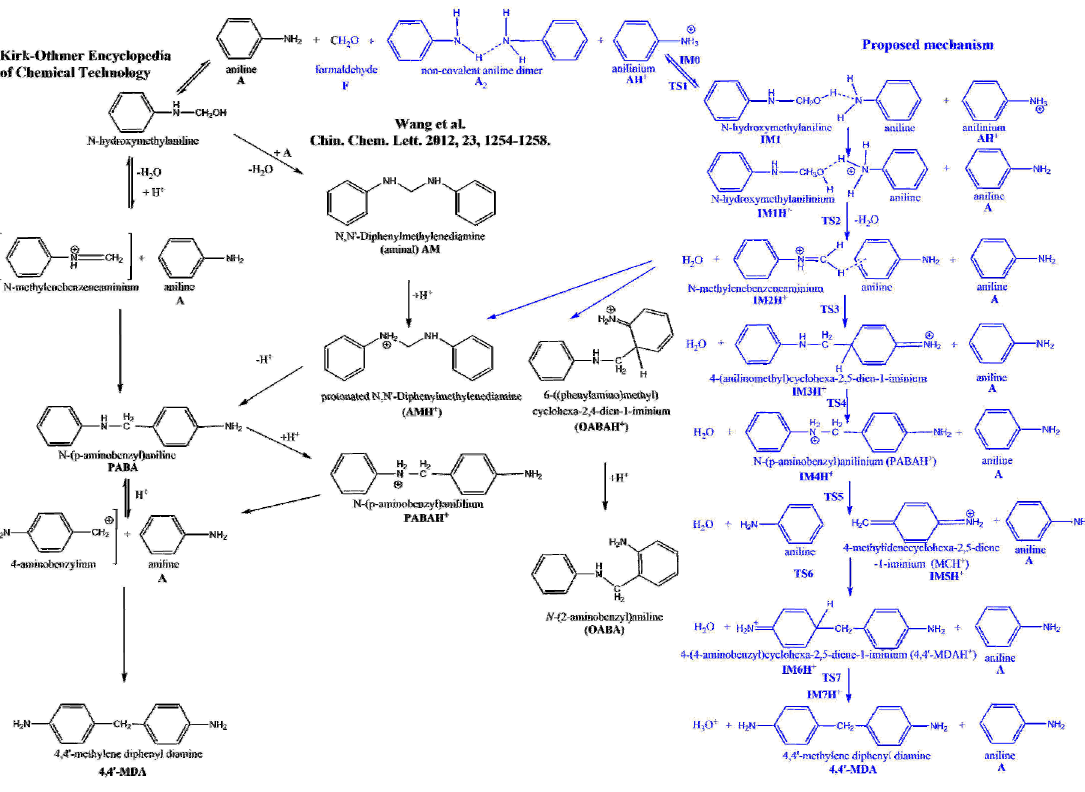
Figure 1. Overall reaction mechanism for methylene diphenyl diamine (methylenedianiline, MDA) synthesis according Kirk–Othmer Encyclopedia of Chemical Technology [12] as well as Wang [13] compared with our proposed mechanism based on G3MP2B3 computation.